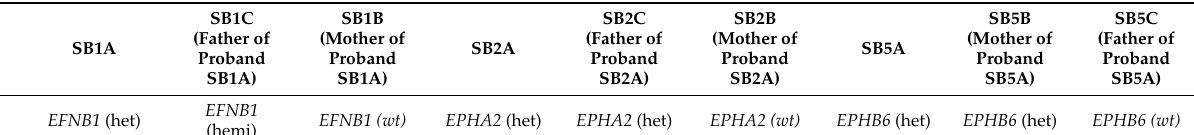
Table 5. The predicted impact of the spina bifida-related variants on the potential interaction with the Eph and ephrin candidates in